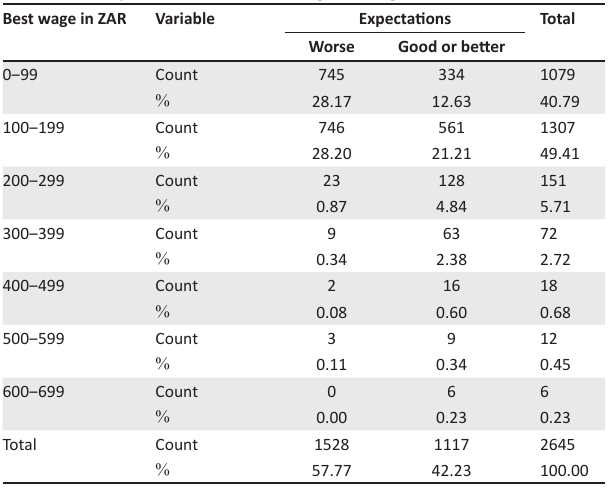
TABLE 7: Descriptive statistics for best wage in